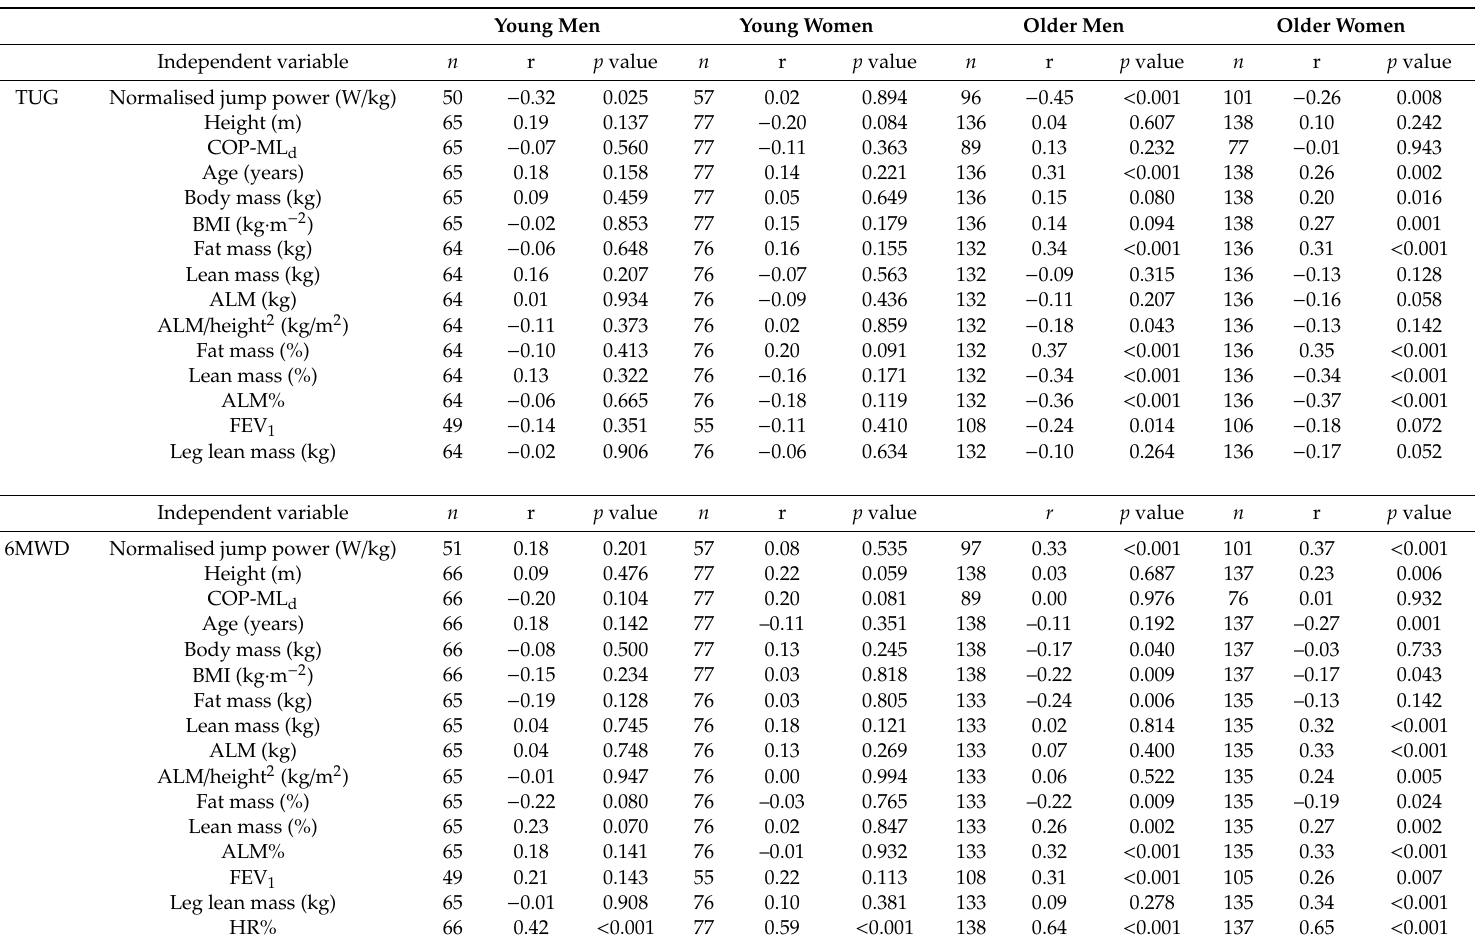
Table 2. Bivariate associations between independent variables, the timed up-and-go test and the six-minute walk